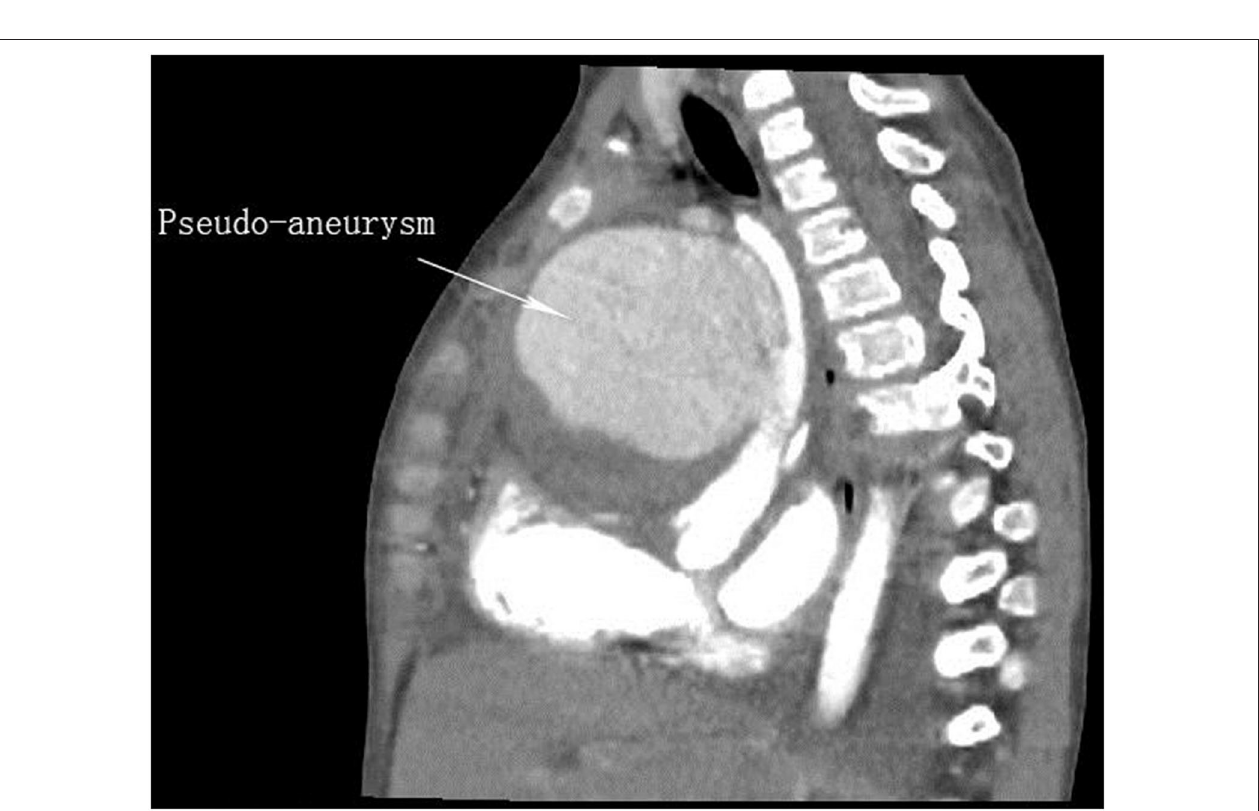
FIGURE 2 | Sagittal view of contrast enhancement CT image shows a large pseudo-aneurysm is bound up with the ascending aorta.